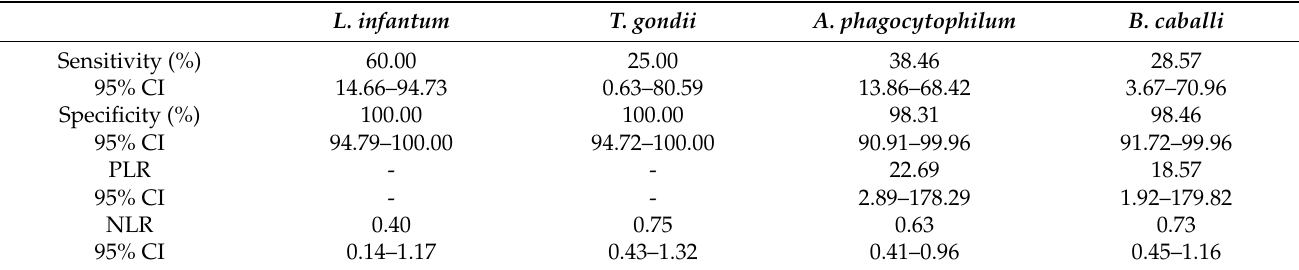
Table 4. Sensitivity, specificity, positive likelihood ratio (PLR) and negative likelihood ratio (NLR) of aqueous humor, when cut off value is